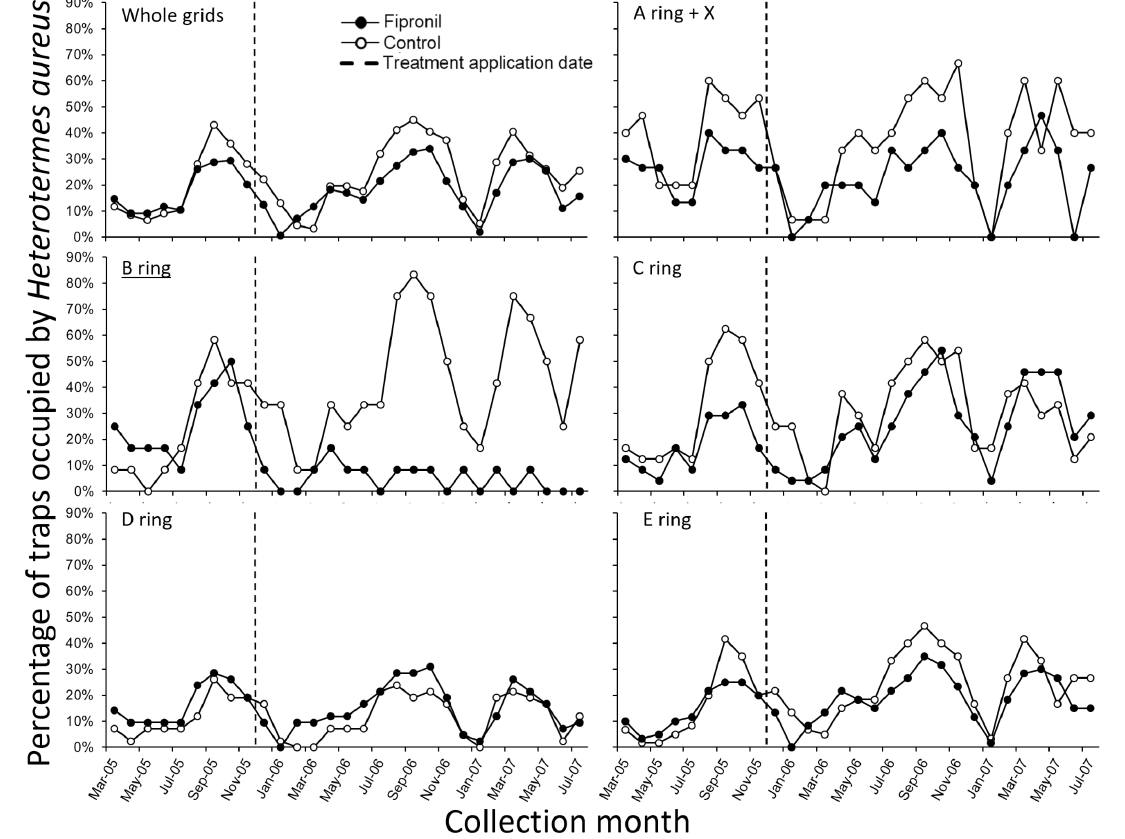
Fig 3 . Average percentage of termite stations occupied by H. aureus per month in whole control and fipronil experimental grids and each of their sections (n= 3 for each treatment). Labels for every other collection month are included in the horizontal axes. The names of grid sections for which analysis showed a significant change in the percentage of stations occupied by H. aureus with respect to controls after treatment application are shown Table 2 . Results of mixed-effects multiple linear regression models for differences between control and fipronil-treated experimental grids based on the percentage of stations occupied by H. aureus . Parameter estimates are displayed with their 95% confidence intervals. For the interaction term, positive parameter estimates imply higher percentages of stations occupied by H. aureus relative to controls after treatment, while negative values imply a decrease. Only fixed effects are included.